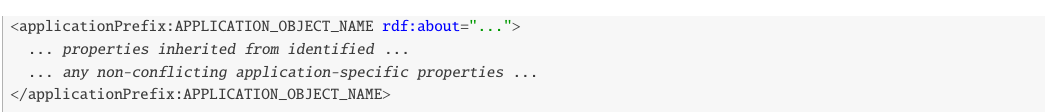
Figure 21: Diagram of the GenericTopLevel class and its associated properties, which is used for embedding externally defined entities into SBOL